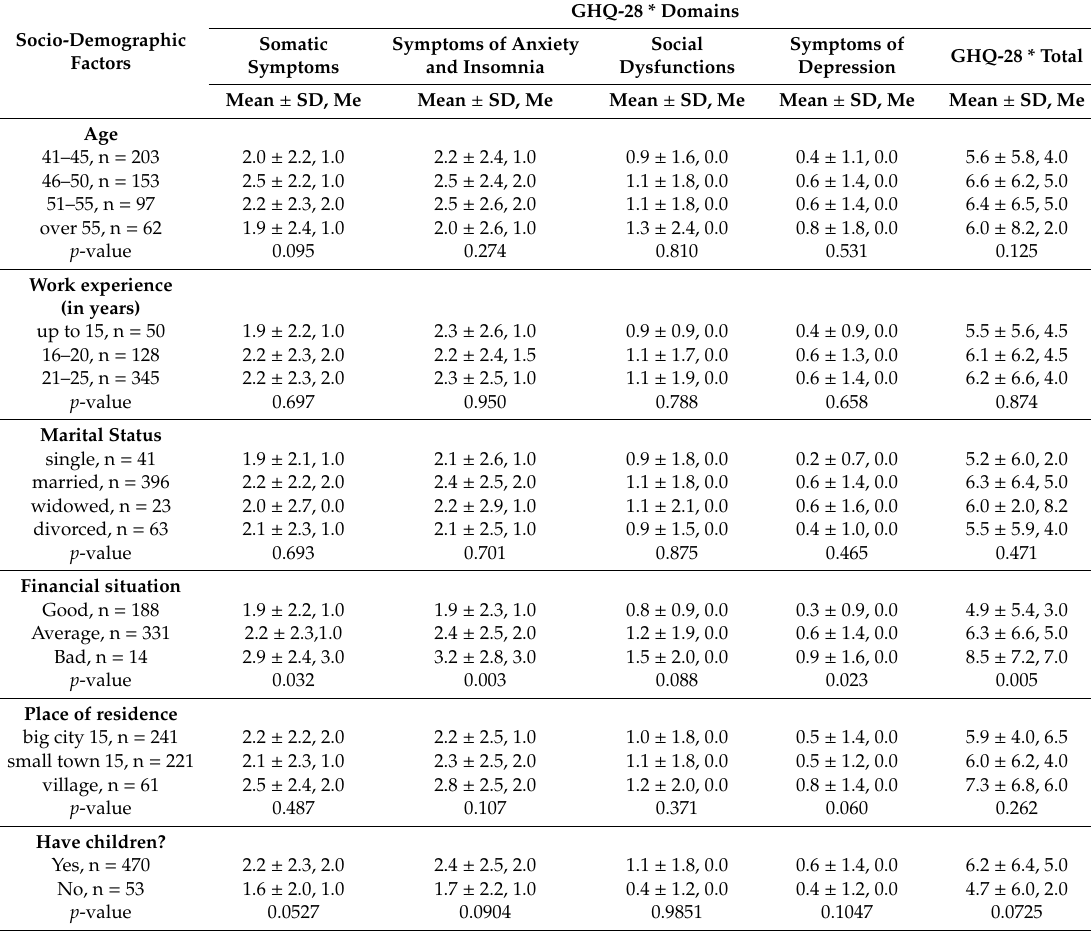
Table 1. Selected socio-demographic factors and respondents’ mental health